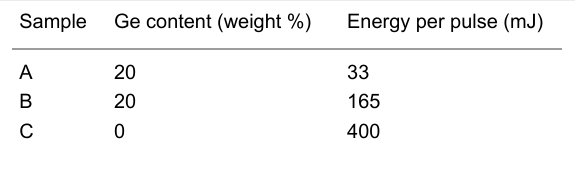
Table 1: Sample name, Ge content and employed energy per